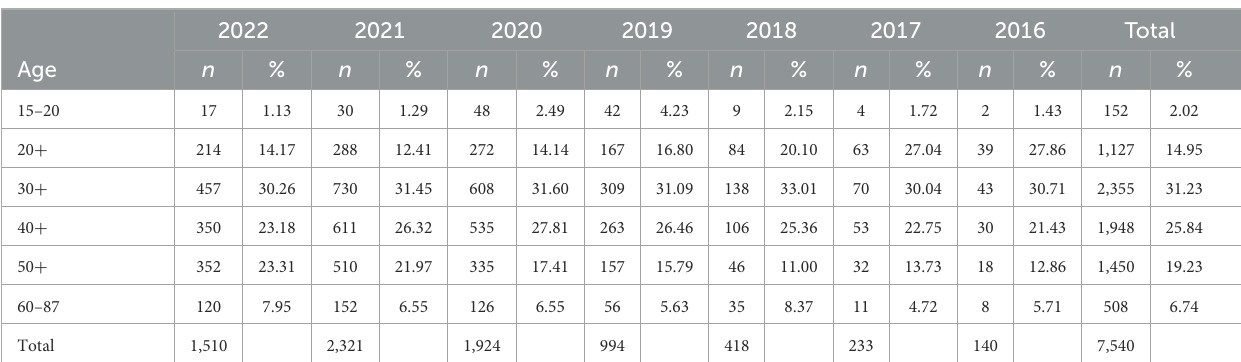
TABLE 2 Annual age distribution in 7,540 HR-HPV positive women. 2022